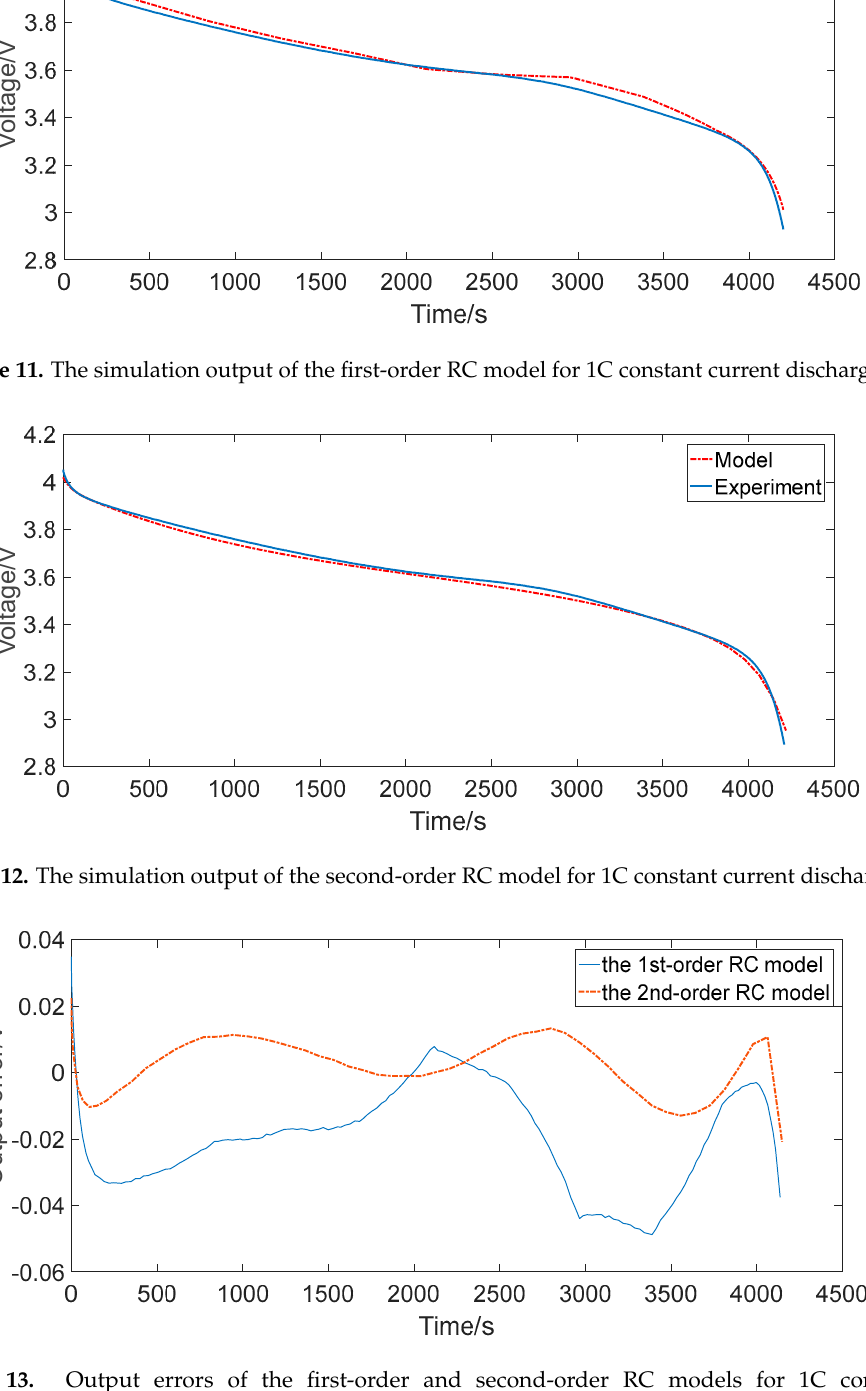
Figure 13. Output errors of the first-order and second-order RC models for 1C constant current discharging.